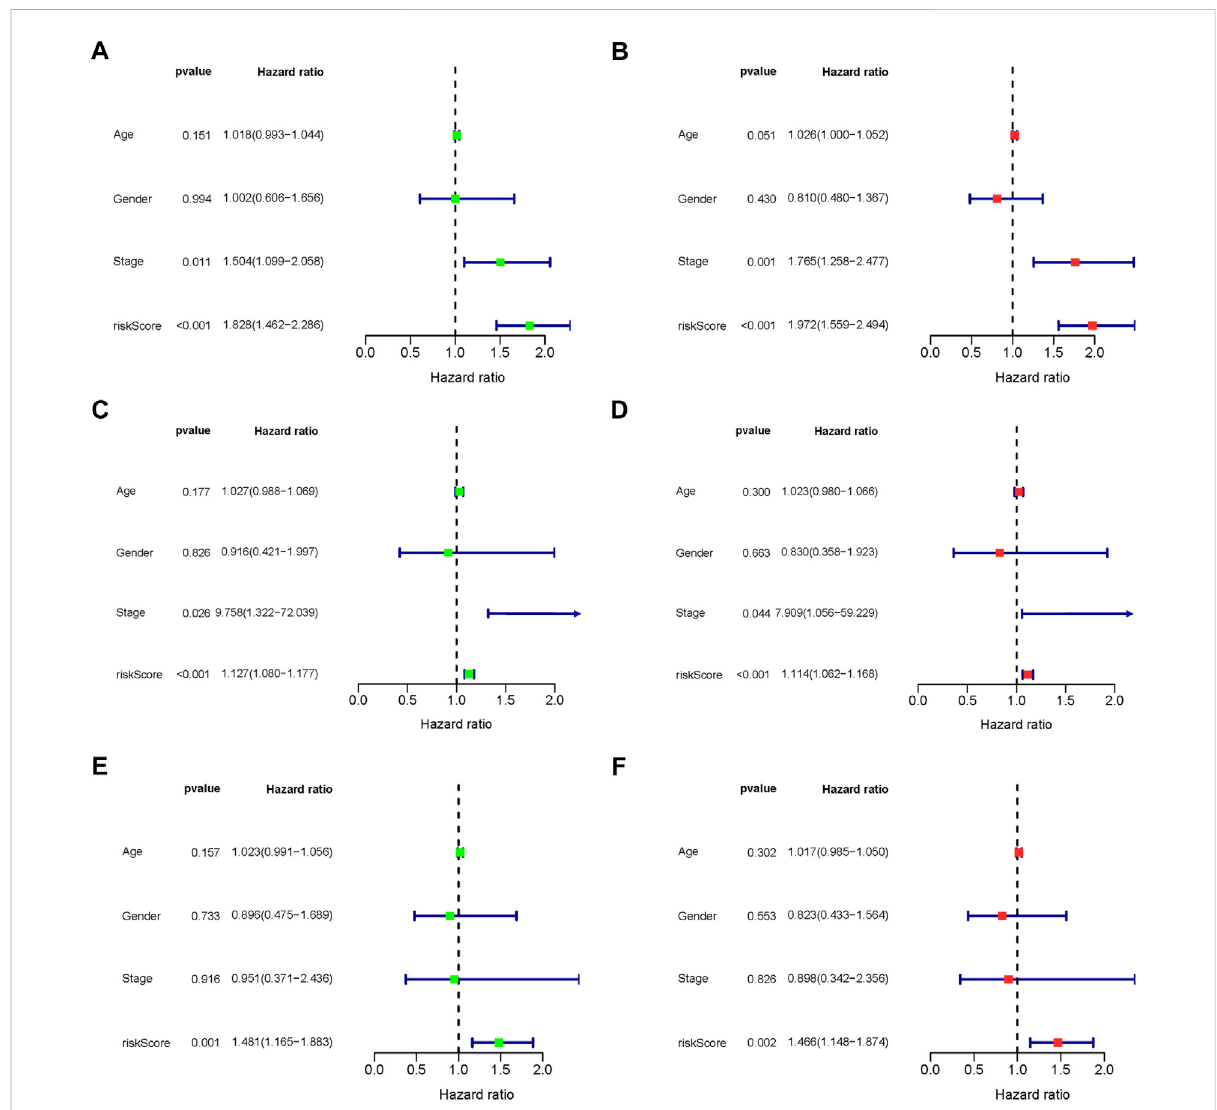
FIGURE 8 Forestplotofclinicalfactorsprognosticanalysis. (A – B) Overall-stageSTAD; (C – D) early-stageSTAD;and (E – F) progressive-stageSTAD. (A,C,E) Univariate analysis of clinical factors. (B,D,F) Multivariate analysis of clinical factors. The dotted line indicates risk ratio (HR) = 1, the green or red rectangle to the left of the dotted line indicates that the clinical factor is a protective factor for STAD (HR < 1), and the green or red rectangle to the right of the dotted line indicates that the clinical factor is a risk factor for STAD (HR >